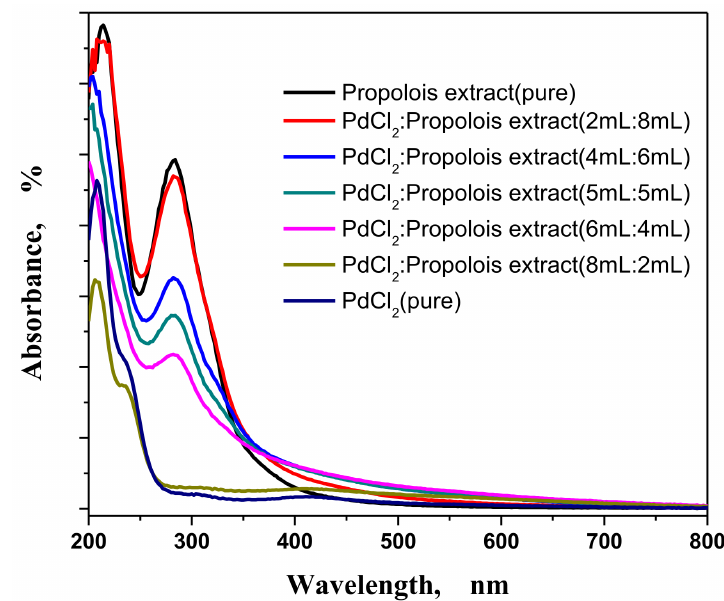
Figure 2. The effect of ratio on biosynthesis of palladium